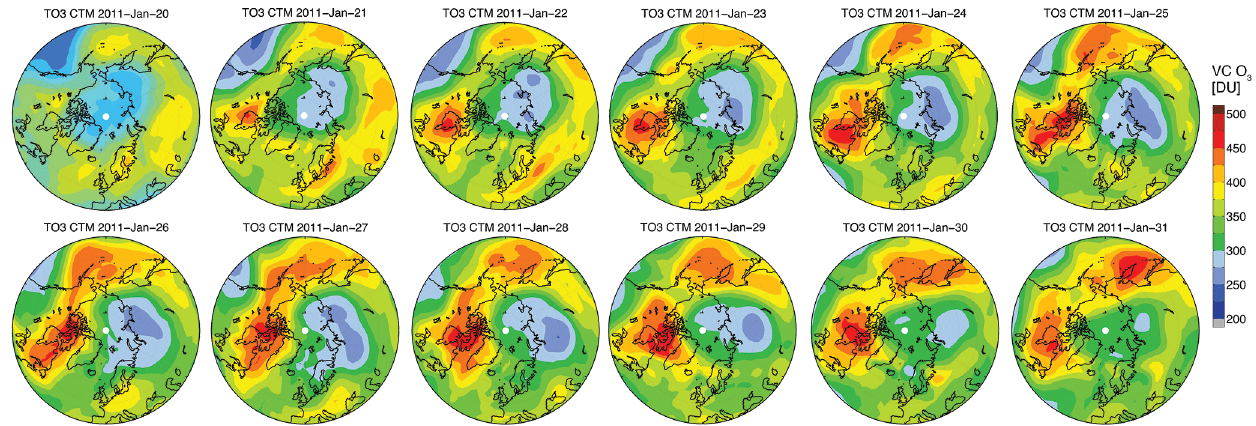
Fig. 14. As in Fig. 13, except for model total ozone. In contrast to Fig. 4, here the Fortuin and Kelder (1998) climatology of tropospheric ozone was added to the model’s stratospheric ozone column in order to cover the entire atmosphere.